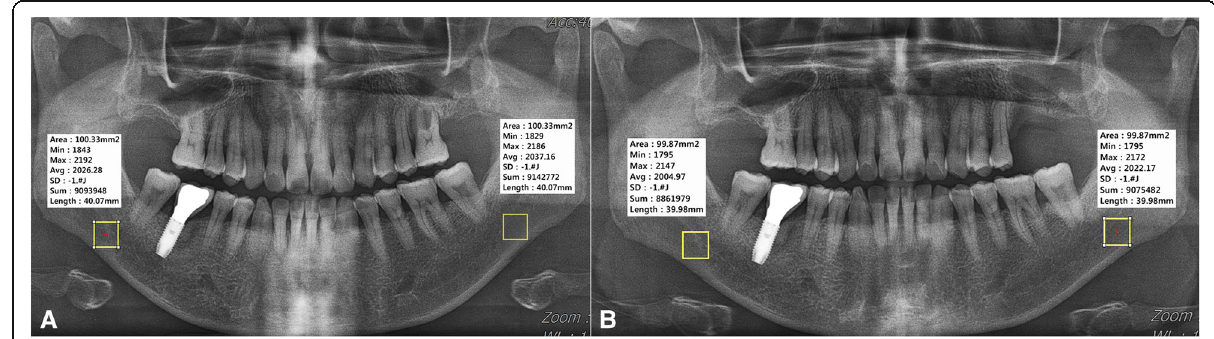
Fig. 2 Comparison of photographic density in normal control group number 9 ( a ), and panoramic radiograph of the same patient taken another day ( b ). These figures were used for only method description from unrelated research data in osteomyelitis